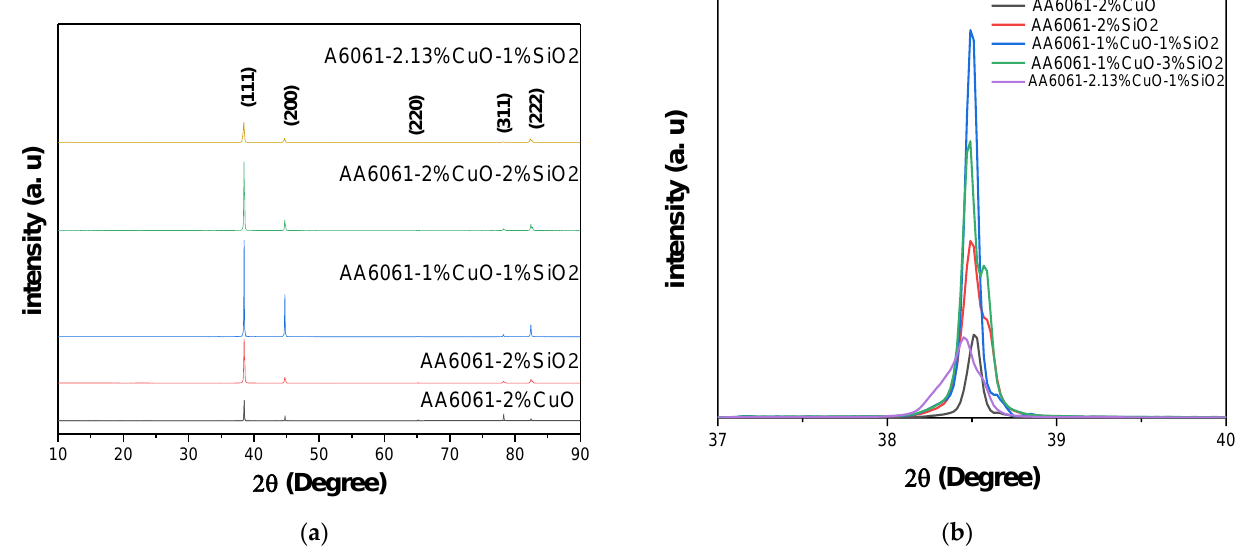
Figure 20. ( a ) XRD intensity pattern; and ( b ) XRD diffraction for peak (1,1,1). Table 15. Crystallite size of samples at peak (1,1,1).